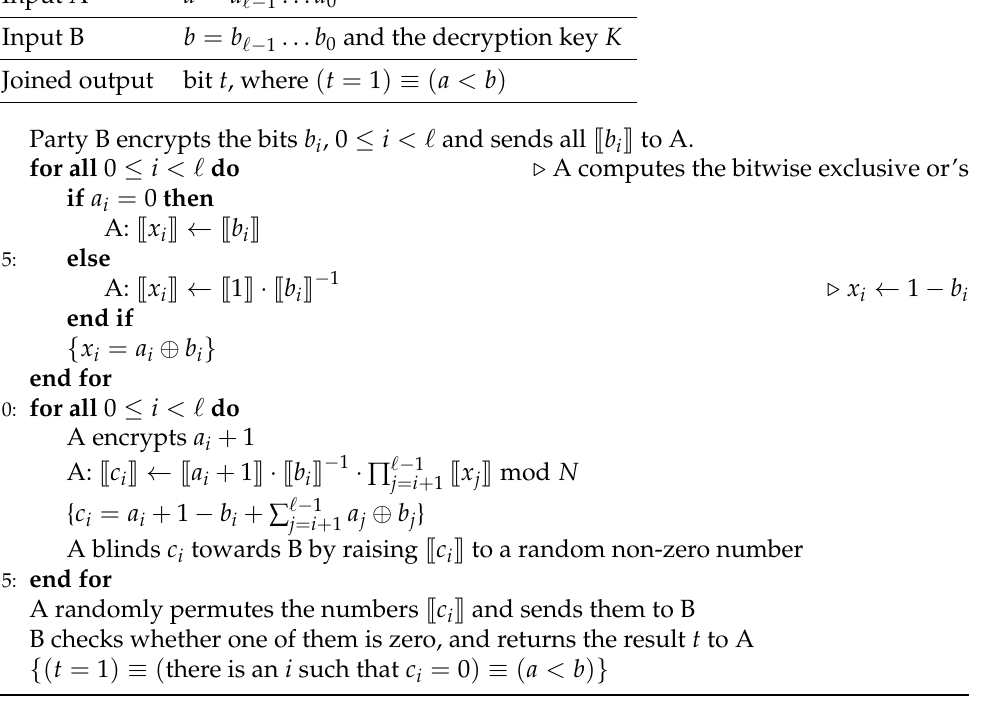
Algorithm 3 The Damgård, Geisler, and Krøigaard (DGK) comparison protocol. Input